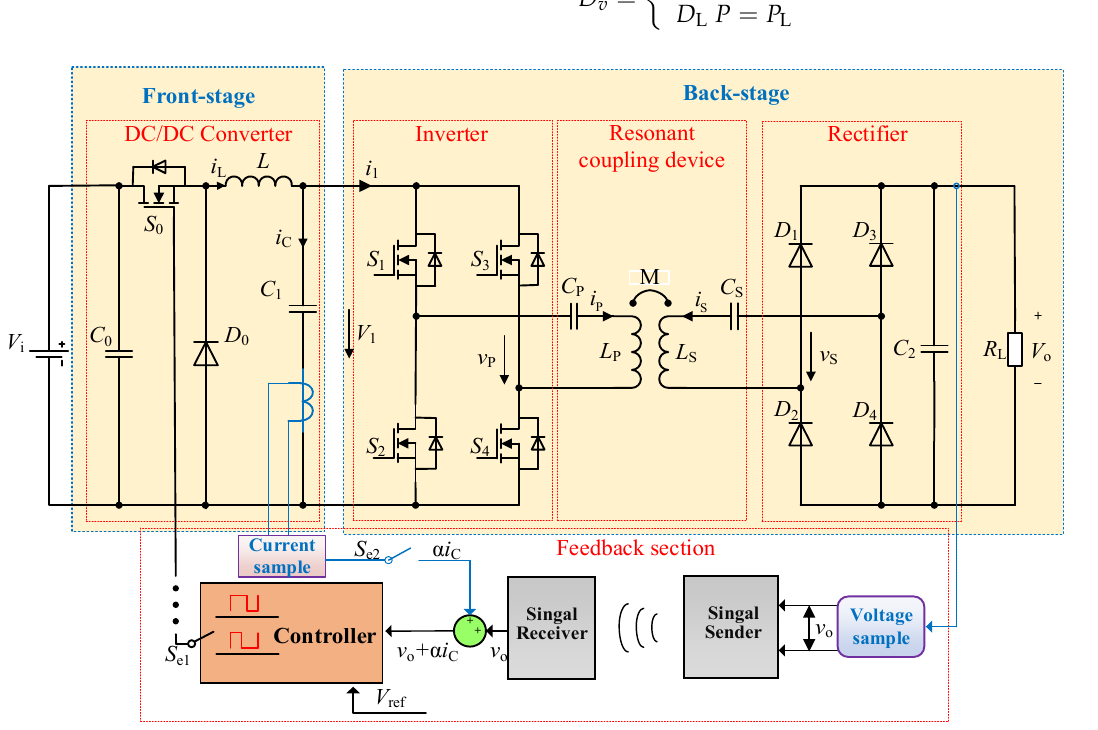
Figure 3. Schematic of the proposed WPT system.